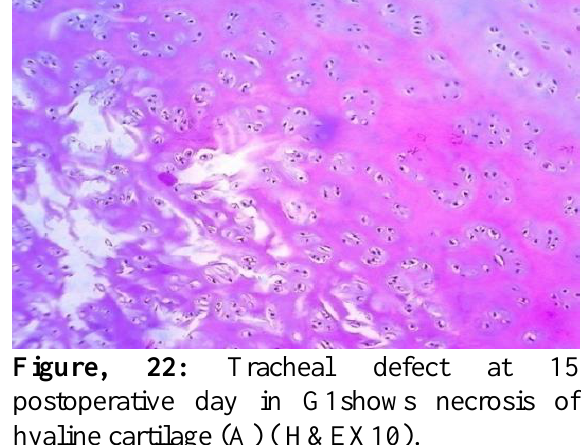
Figure, 17: Tracheal defect at 15 postoperative day in G1 shows infiltration of inflammatory cells (A) and hyperplasia of epithelium lining cells (B) ( H&E X).